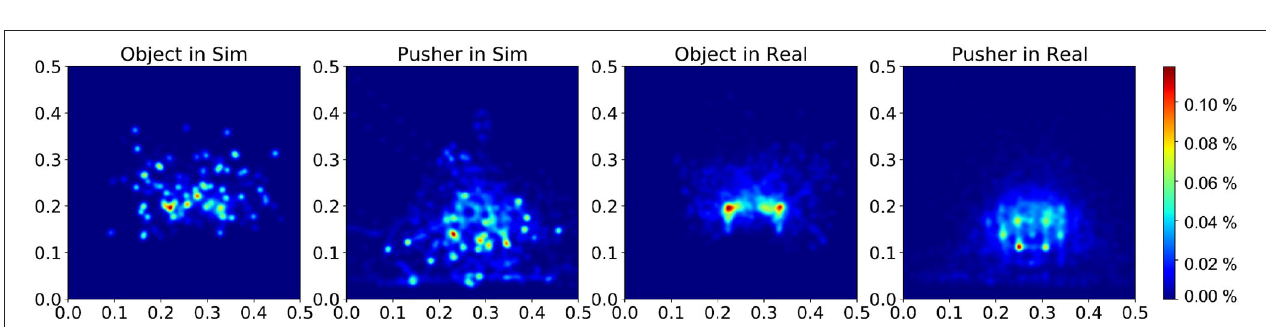
FIGURE 10 | Distribution of the object and pusher’s position during tests in simulation and real experiments. The color bar represents the occurrence frequency.